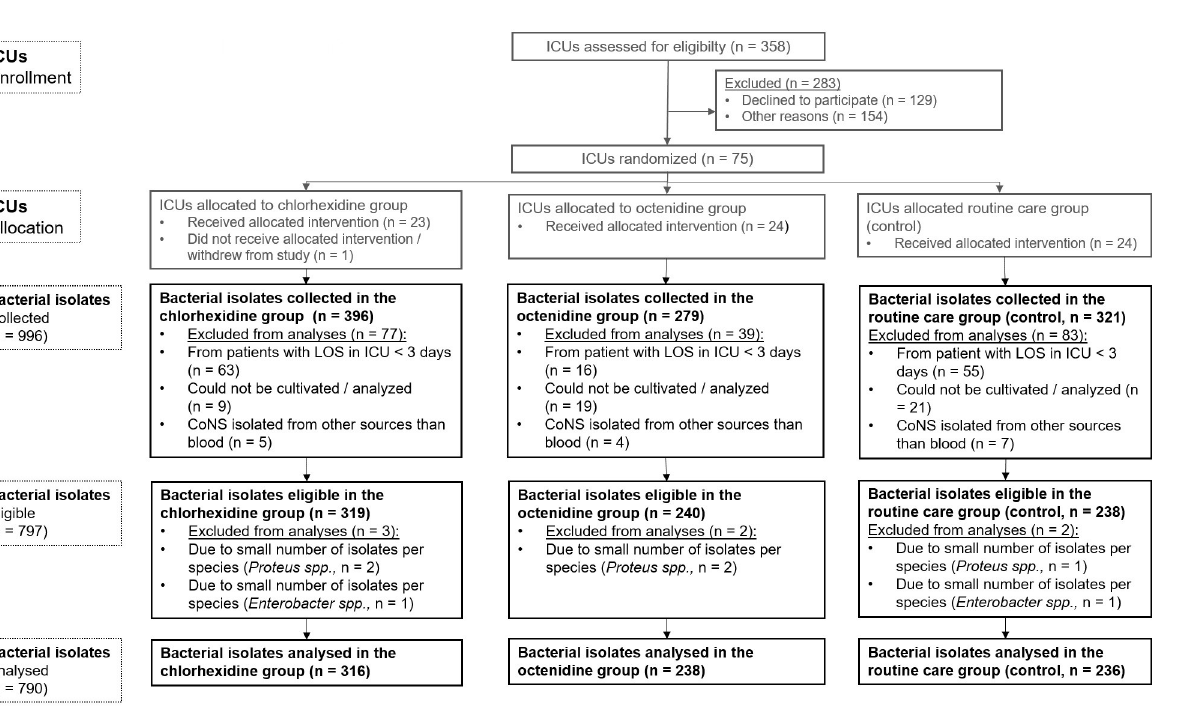
PLOS ONE | https://doi.org/10.1371/journal.pone.0278569 December14,